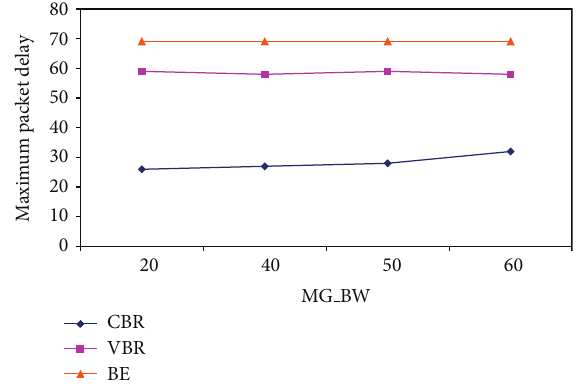
Figure 9: Maximum delay suffered for different values of 𝛽 when 𝛼 and 𝜆 are kept constant.